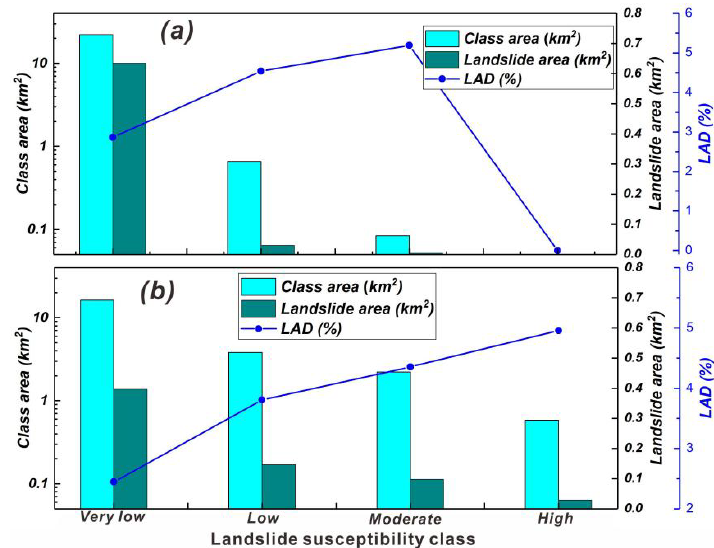
Figure 21. Susceptibility class distribution and the occurrence of landslides within the study area; ( a ) before rainfall; ( b ) after rainfall.